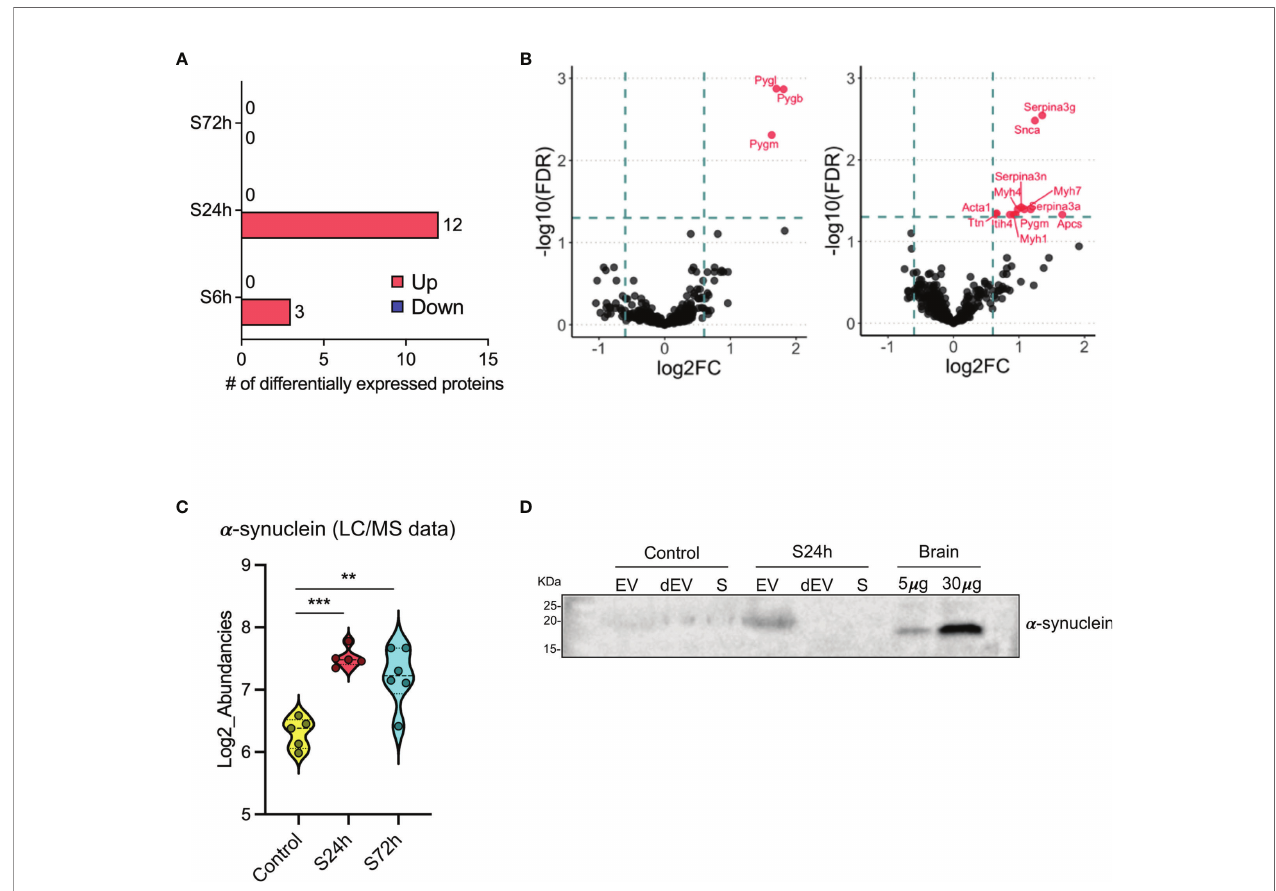
FIGURE 4 | Differential expression of proteins in the post-surgery circulating EVs. (A) Bar diagram representing the number of differentially expressed proteins in the 6, 24, and 72 h post-surgery groups compared to the control values as assessed by GraphPad Prism (v. 9.1.1) using multiple unpaired t-tests analysis with FDR < 0.05 and fold change (FC) > 1.5. ( Materials and Methods ). (B) Volcano plots showing the differentially expressed proteins at 6h (left) and 24h (right) post-surgery compared to their corresponding control groups (C6h and CS24-72h). Dotted lines represent FC > 1.5 threshold (log2-FC) and FDR <0.05 (-log10FDR), respectively. (C) Differential expression of a -synuclein in the EVs from S24h and S72h groups using log2-transformed LC/MS data. (D) a -synuclein expression validation by western blot. Mouse brain (hippocampus) homogenate was used as a positive control. SDS-PAGE was run under non-reducing conditions. dEV, serum depleted of EVs, S, serum. Snca in the 24h Volcano plot is the of fi cial gene symbol for a -synuclein ( a -syn). **p < 0.005, ***p <